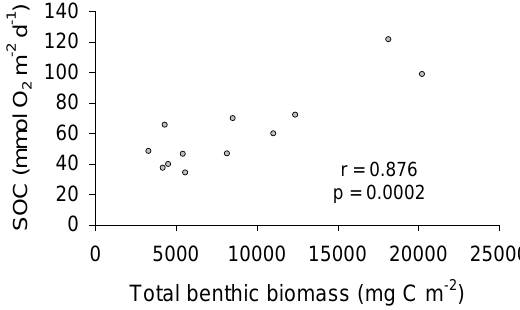
Fig. 5. Relationship between SOC (mmol O 2 m − 2 d − 1 ) and total benthic (macrofauna and bacteria) biomass (mgCm − 2 ).